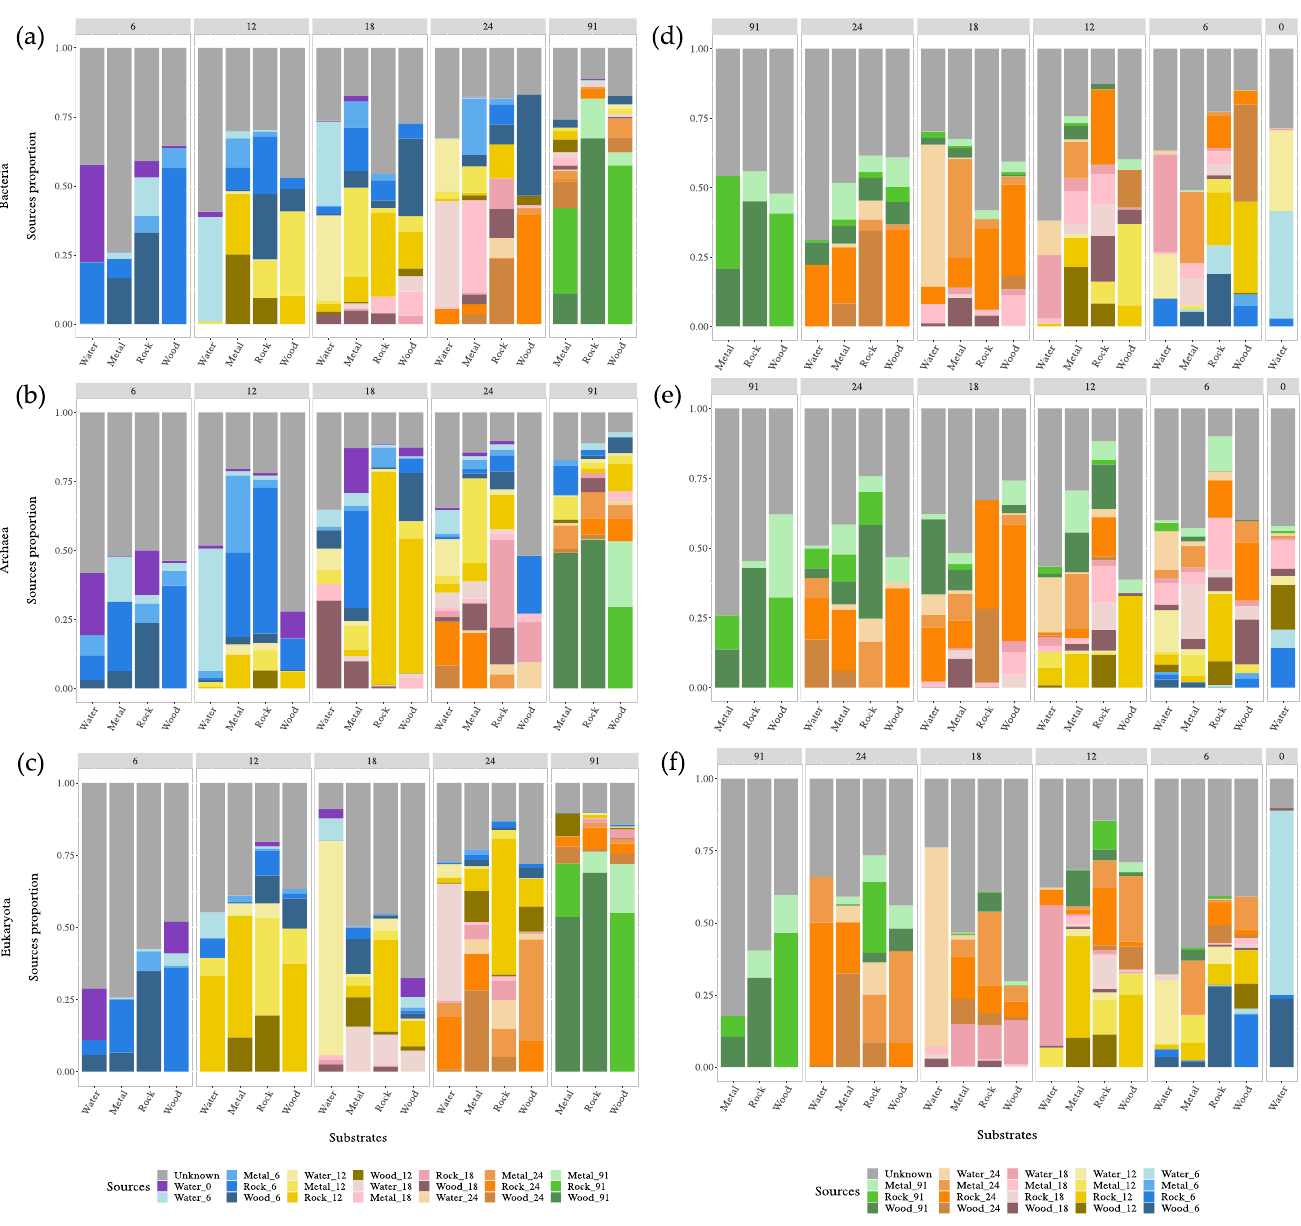
Figure 5. Microbial source tracking analyses estimating the contribution of planktonic bacterial ( a ), archaeal ( b ) and eukaryote ( c ) communities from the deeper (12 m) into the surficial layers or bac- terial ( d ), archaeal ( e ), eukaryoteota ( f ) from surficial (12 m) into the deeper layer (24 m) communi- ties, across the depth gradient (m). The unknown sources are indicated in grey. Each source corre- spond to a layer in the depth gradient (m).